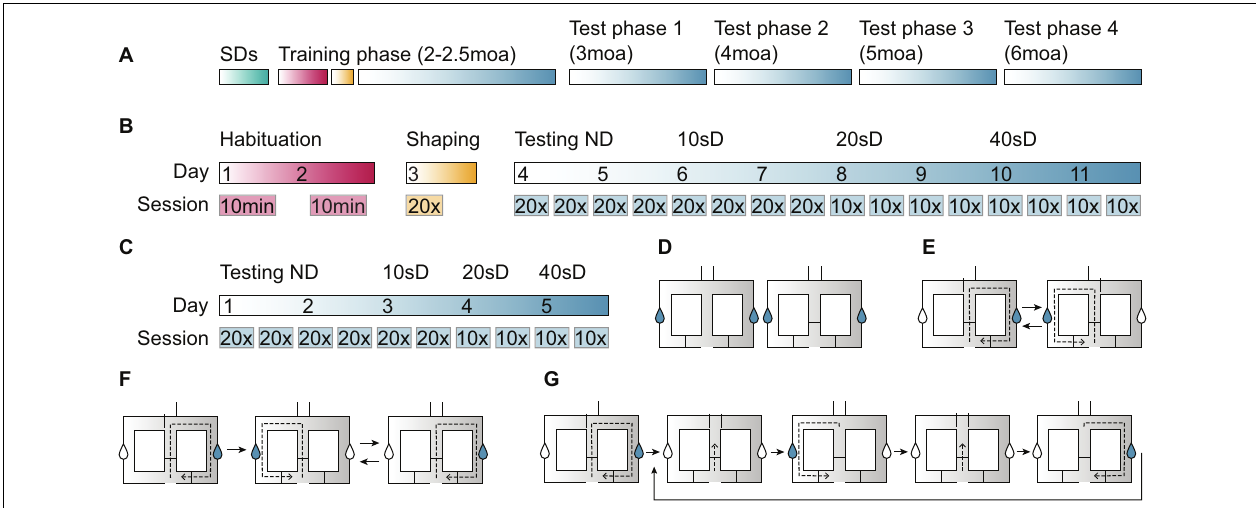
FIGURE 2 | Illustration of the delayed alternation task (DAT) procedure in the figure-8-maze. (A) After being exposed to swing doors (SDs) in the home cage for 2 days (green), mice performed a DAT training phase at 2–2.5 moa and were tested at 3, 4, 5, and 6 moa. (B) In the training phase, mice were exposed to the maze during two habituation sessions (red), performed 20 shaping trials (yellow), and had four testing sessions at each of the four delays (no delay, 10-, 20-, and 40-s delay) (blue). (C) Test phases consisted of four no-delay sessions and two sessions of the 10-, 20-, and 40-s delays. (D) During habituation sessions, mice were free to explore the maze with the motorized doors open and either 2 (day 1, left image) or 3 (day 2, right image) SDs present. Sucrose-containing rewards (blue drops in graphical representation) could be obtained at either side of the maze. (E) During the shaping session, mice performed 20 trials of forced alternation. (F) No-delay sessions consisted of a forced run (left image), followed by 20 free run trials, whereby the animal was rewarded when entering the arm that had not been visited on the previous run. (G) In delay sessions, the animal was contained within the middle compartment (second and fourth image) for a period of 10, 20, or 40 s before the motorized doors would open and it could make a